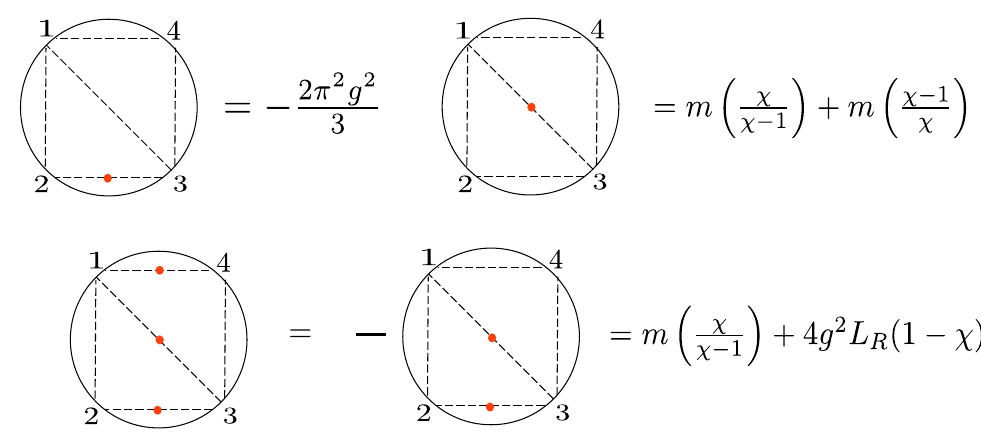
Figure 19 . Various magnon con(cid:12)gurations and their contributions. The red dots denote the magnons. The (cid:12)rst con(cid:12)guration is ( 1-particle ) while the second is ( bulk 1-particle ). The third and the fourth con(cid:12)gurations are ( 3-particle ) and ( 2-particle ) respectively. Asymptotic